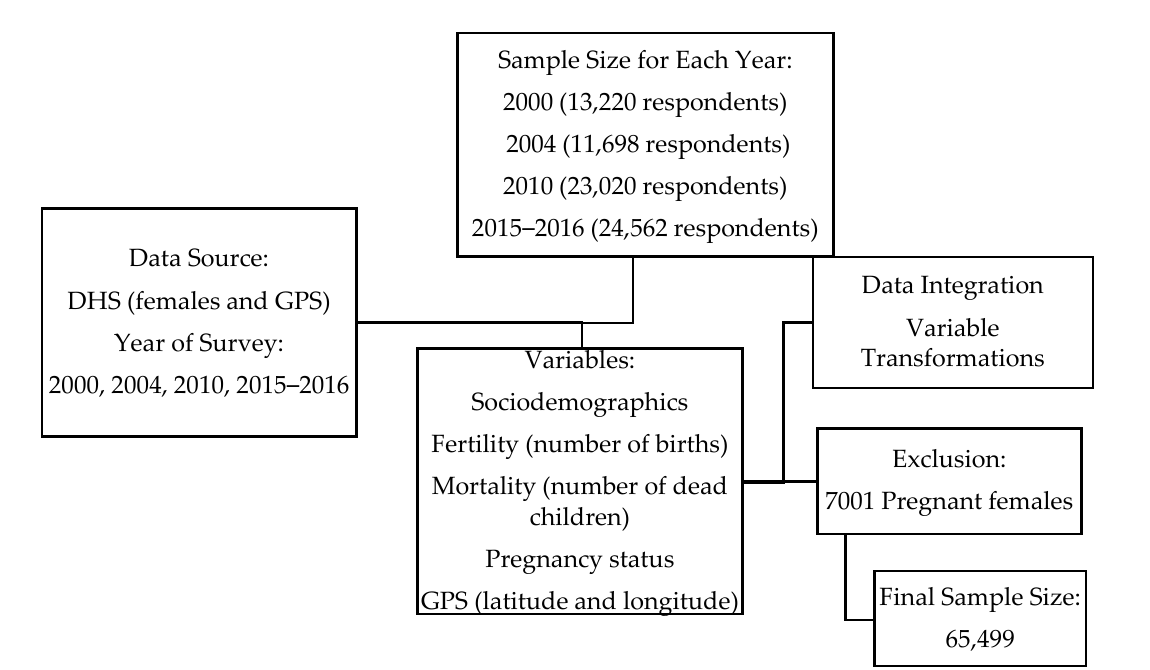
Figure 1. A flowchart outlining data and variable selection. Source: authors’ construct.